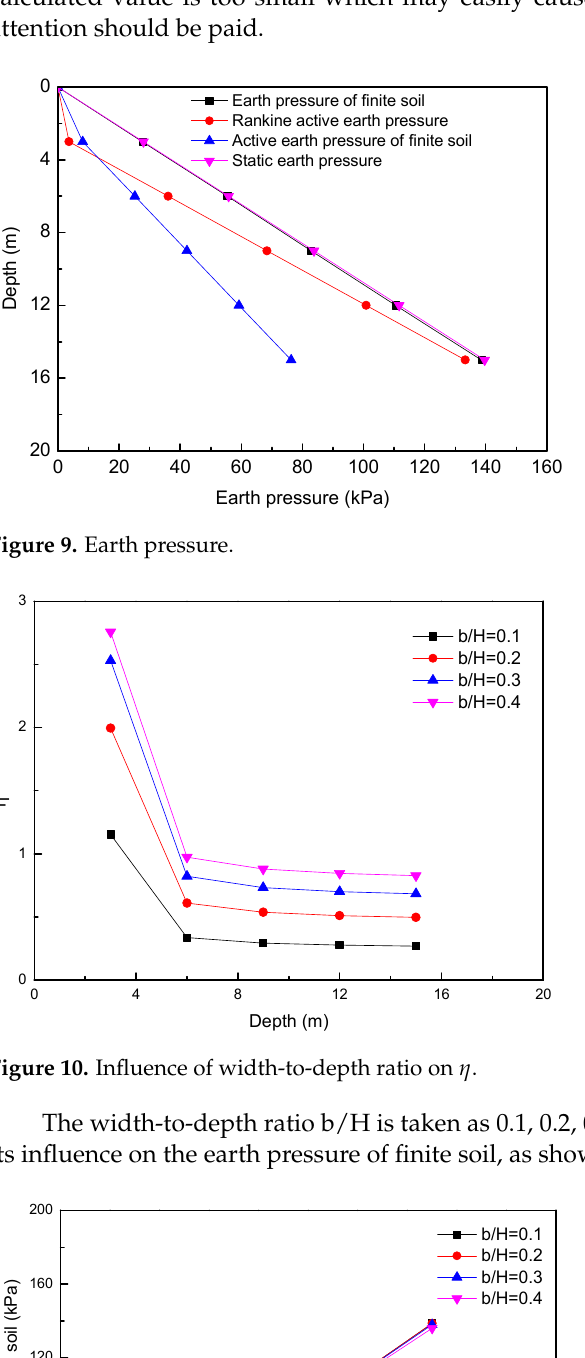
Figure 10. Influence of width-to-depth ratio on η .